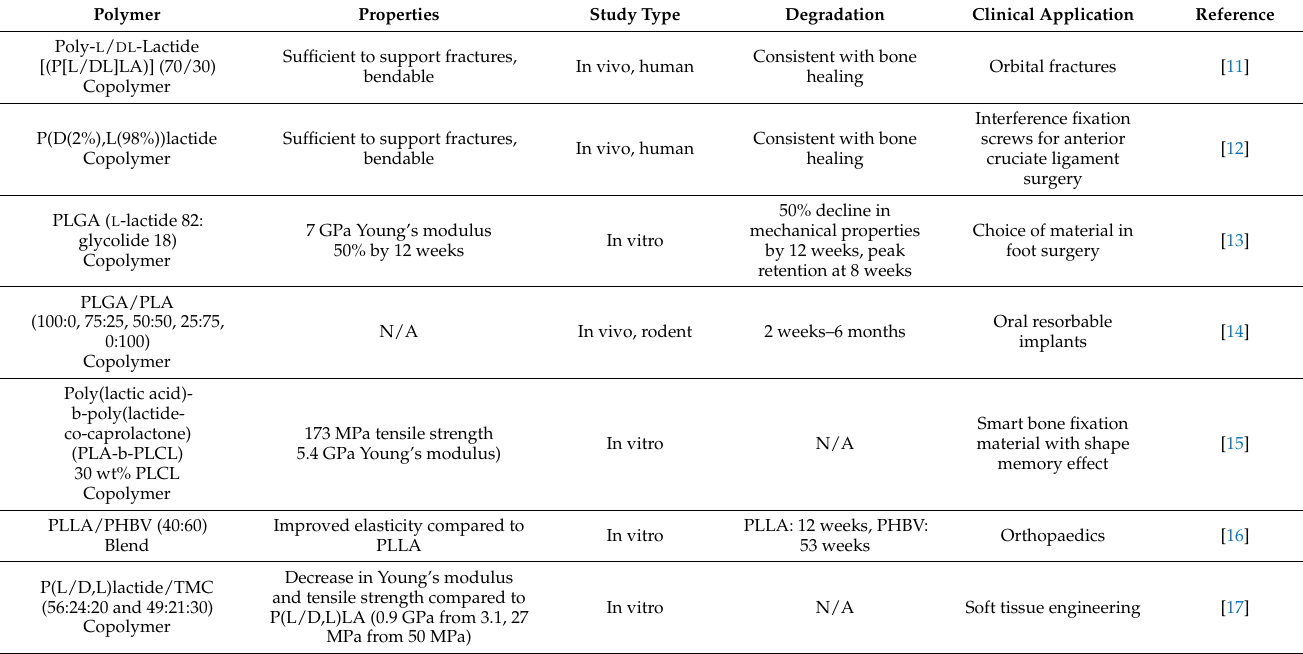
Table 1. Summary of Polymer